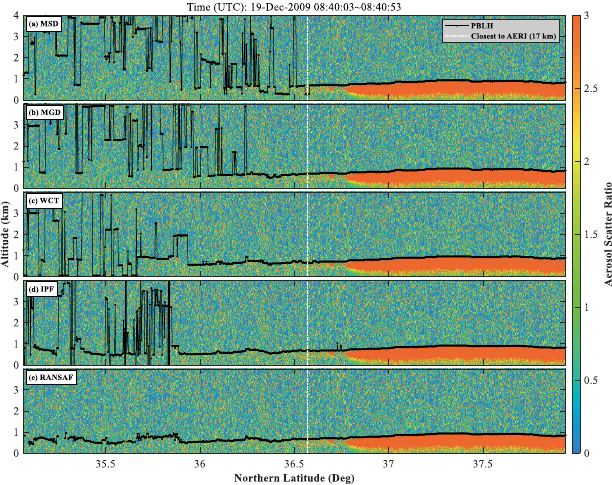
Figure 9. ASR measured using CALIOP from 08:40:03 to 08:40:53 on 19 December 2009 (UTC, nighttime); PBLHs were determined by using ( a ) MSD, ( b ) MGD, ( c ) WCT, ( d ) IPF, and ( e ) RANSAF methods.